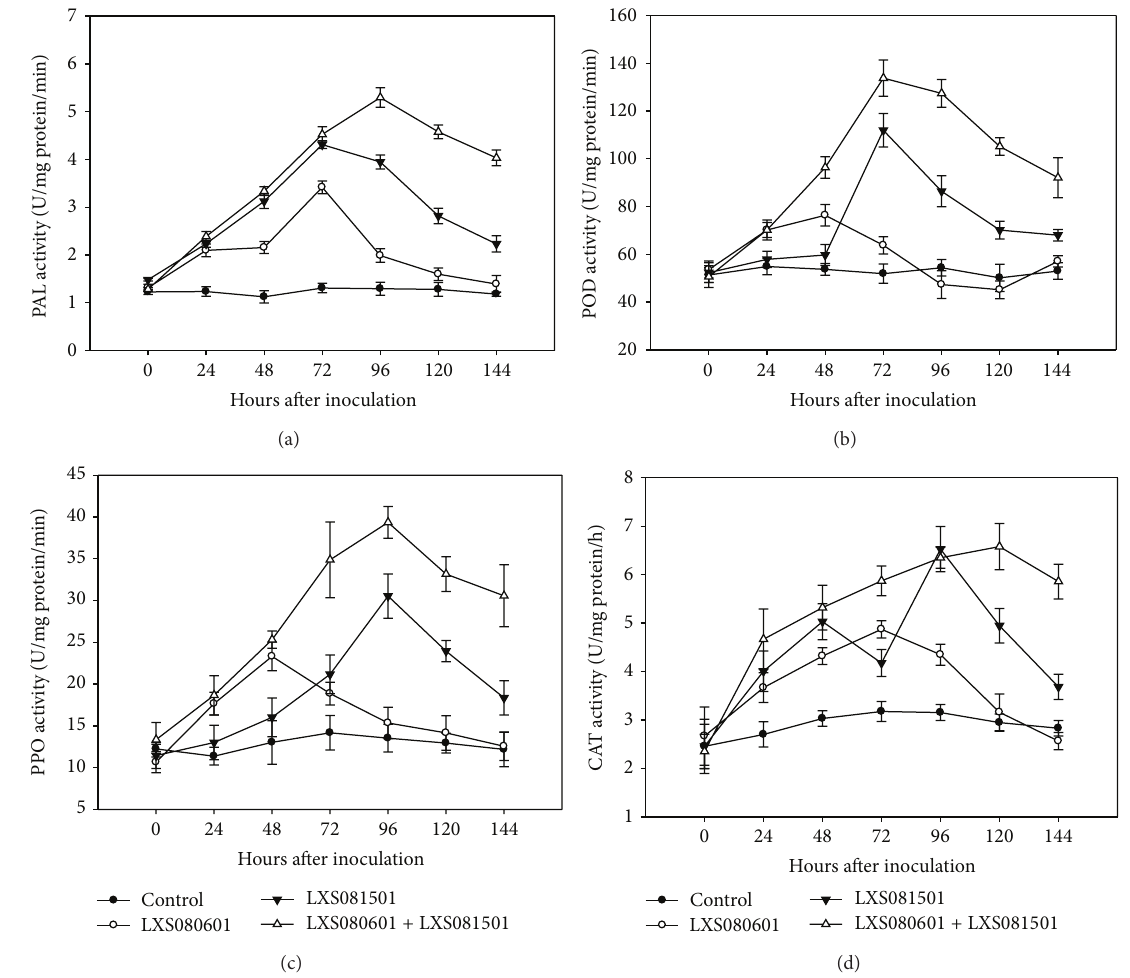
Figure 3: Time course of PAL (a), POD (b), PPO (c), and CAT (d) activities in extracts from apple calli inoculated with PDA (control), LXS080601, LXS081501, and LXS081501 + LXS080601. Data represent the mean of “Fuji” and “Gala” cultivars in two independent experiments. Error bars represent standard error of the